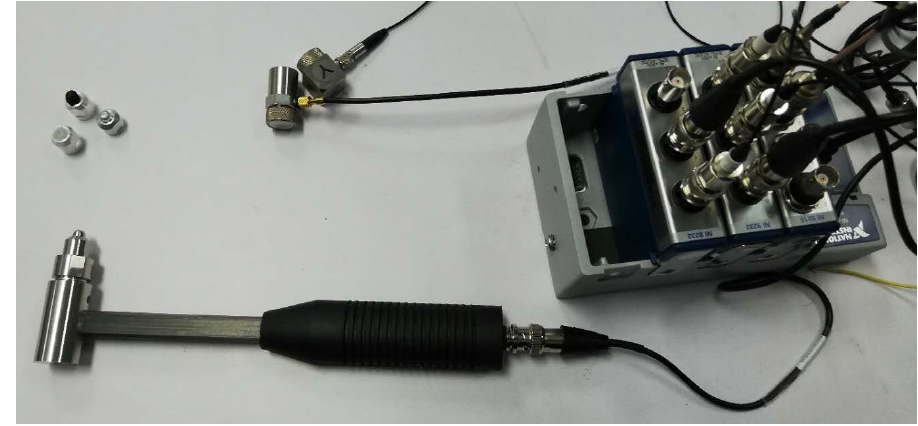
Figure 9. Data acquisition module for collision